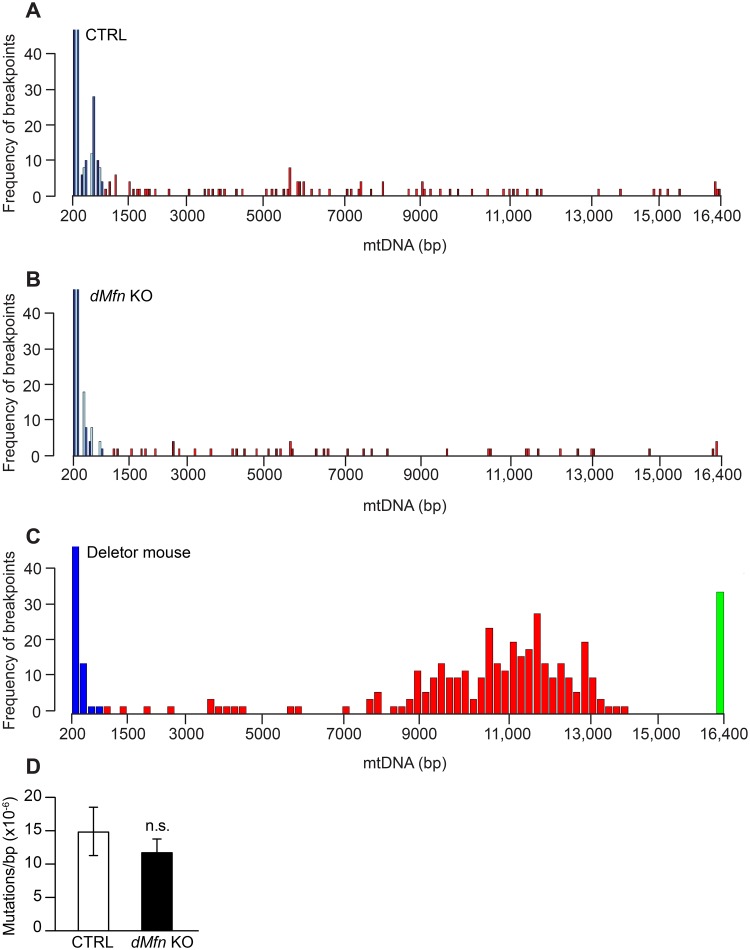
Integrity of mtDNA is unaffected upon loss of mitochondrial fusion.Analysis of mitochondrial DNA rearrangement frequency from hearts of control (A), dMfn KO (B), and Deletor (C) animals at 5 weeks of age as determined by Illumina sequencing (control n = 3; dMfn KO n = 3 and Deletor mouse n = 1). The graphs depict paired-end sequencing reads from individual animals with an abnormally long or short insert size plotted as bins along the x-axis. The frequency of unique rearrangement breakpoints is plotted on the y-axis. Blue bins represent variations in the fragment size and not rearrangement breakpoints; red bins denote rearrangements larger than 600 bases. In the deletor mice, a green bin at position 16,400 kb signifies rearrangement breakpoints encompassing the first and last positions of the reference sequence, leading to difficulties in assessing the true size of the rearrangement. Shades of blue and red indicate different individual animals within a group. (D) Mitochondrial DNA mutation load analysis in heart from control and dMfn KO animals at 5–6 weeks of age, n = 3 for both genotypes. n.s., no statistical significance based on Student T-test.